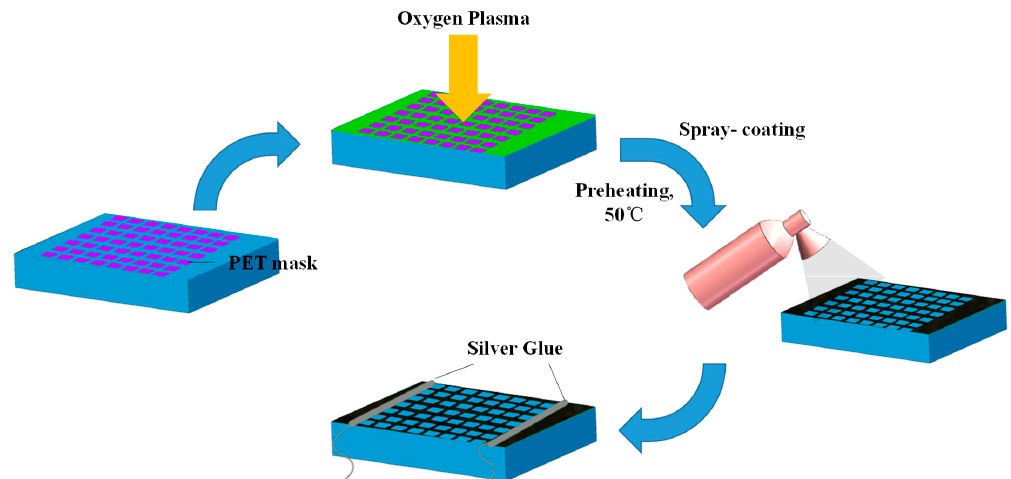
Figure 1. Schematic illustration of graphene flexible strain sensor fabrication process.